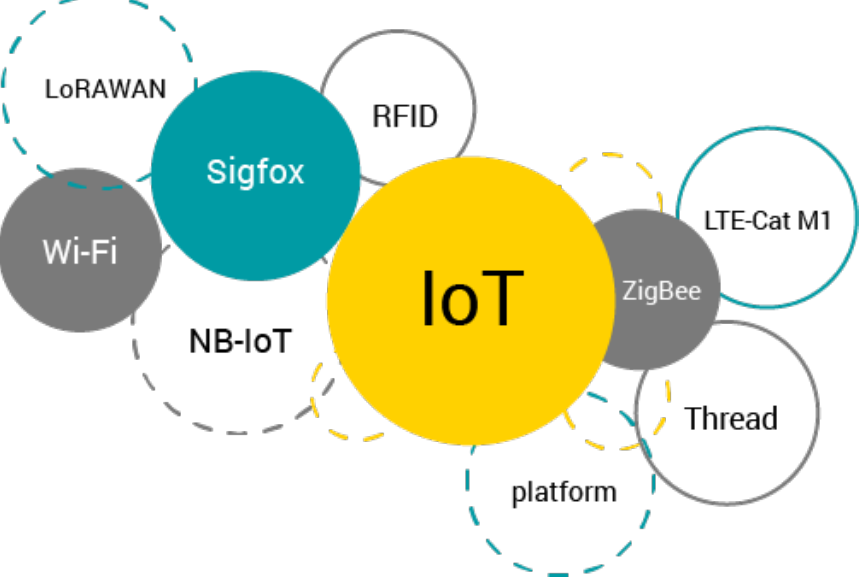
Figure 1. The technology behind the Internet of